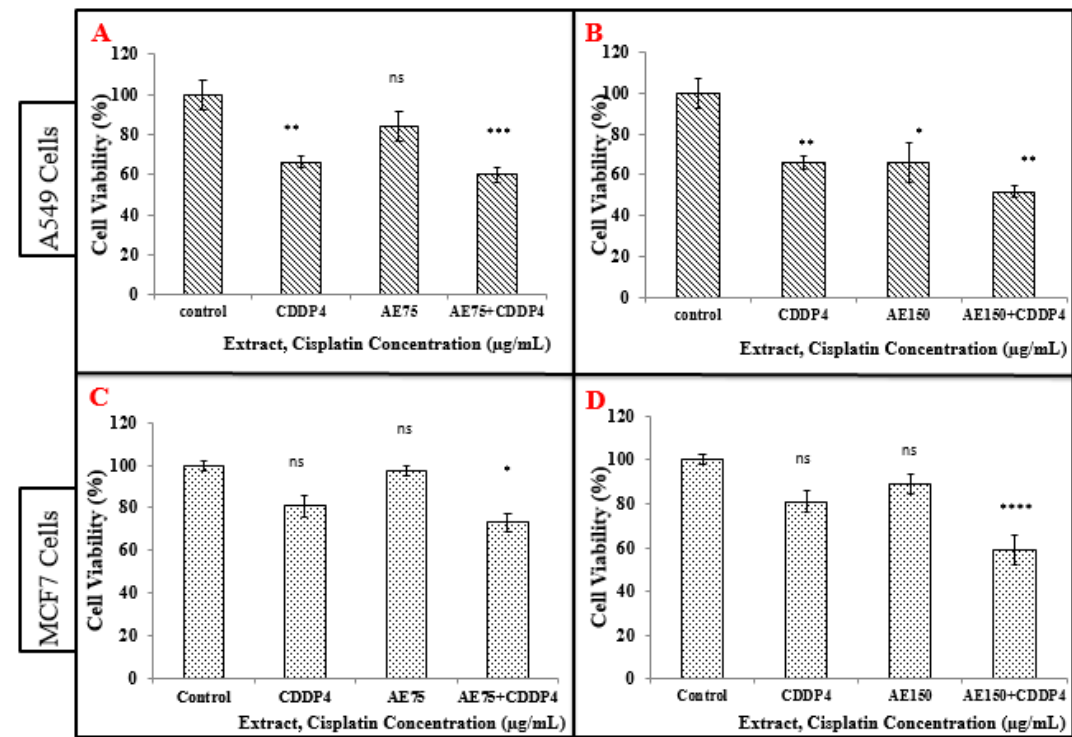
Figure 4. Cell viability of A549 and MCF-7 after treatment for 24 h. ( A ) Cell viability of A549 for 24 h after treatment with CDDP (4 µ g / mL) combined with the aqueous extract (AE 75 µ g / mL). ( B ) Cell viability of A549 for 24 h after treatment with CDDP (4 µ g / mL) combined with the aqueous extract (AE 150 µ g / mL). ( C ) Cell viability of MCF-7 for 24 h after treatment with CDDP (4 µ g / mL) combined with the aqueous extract (AE 75 µ g / mL). ( D ) Cell viability of MCF-7 for 24 h after treatment with CDDP (4 µ g / mL) combined with the aqueous extract (AE 150 µ g / mL) (* p < 0.05, ** p < 0.01, *** p < 0.001, **** p < 0.001).